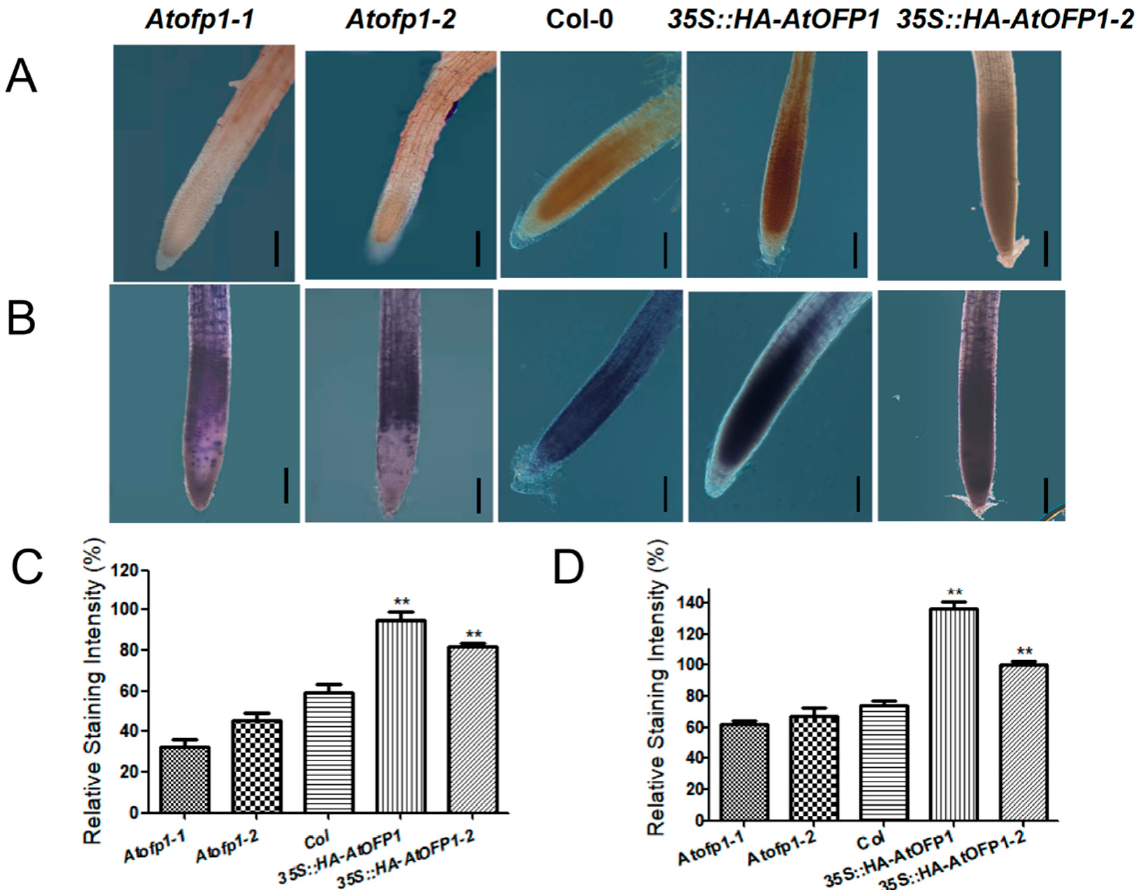
Figure 6. 35S::AtOFP1 OE line accumulates more ROS than the Col-0 in root tips. ( A , C ) represent DAB staining for H 2 O 2 in primary root rips of the 10-day-old Atofp1-1, Atofp1-2, Col-0, 35S::AtOFP1 , and 35S::HA-AtOFP1-2 lines. ( B , D ) NBT staining for superoxide in primary root rips of the 10-day-old Atofp1-1, Atofp1-2, Col-0, 35S::AtOFP1 , and 35S::HA-AtOFP1-2 lines. Bars = 50 µm. DAB and NBT staining intensity were determined with Adobe Photoshop CC2019 ( C , D ). Asterisk (**) indicates significantly different from Col wild-type ( p < 0.01).